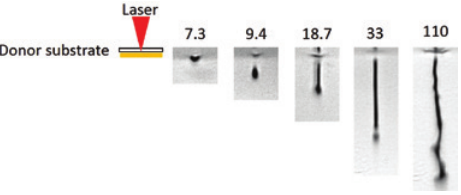
Figure 9: Time-resolved shadowgraphy images of the ejection of melted copper in double-pulse LIFT